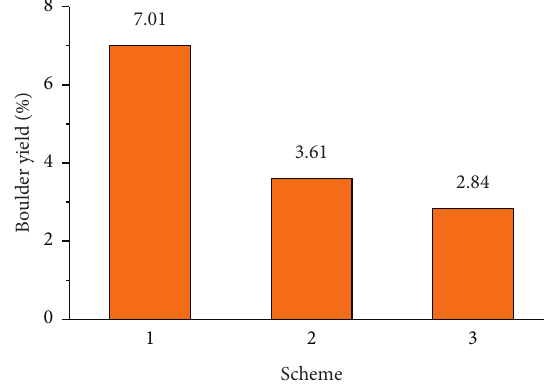
Figure 13: Boulder yield